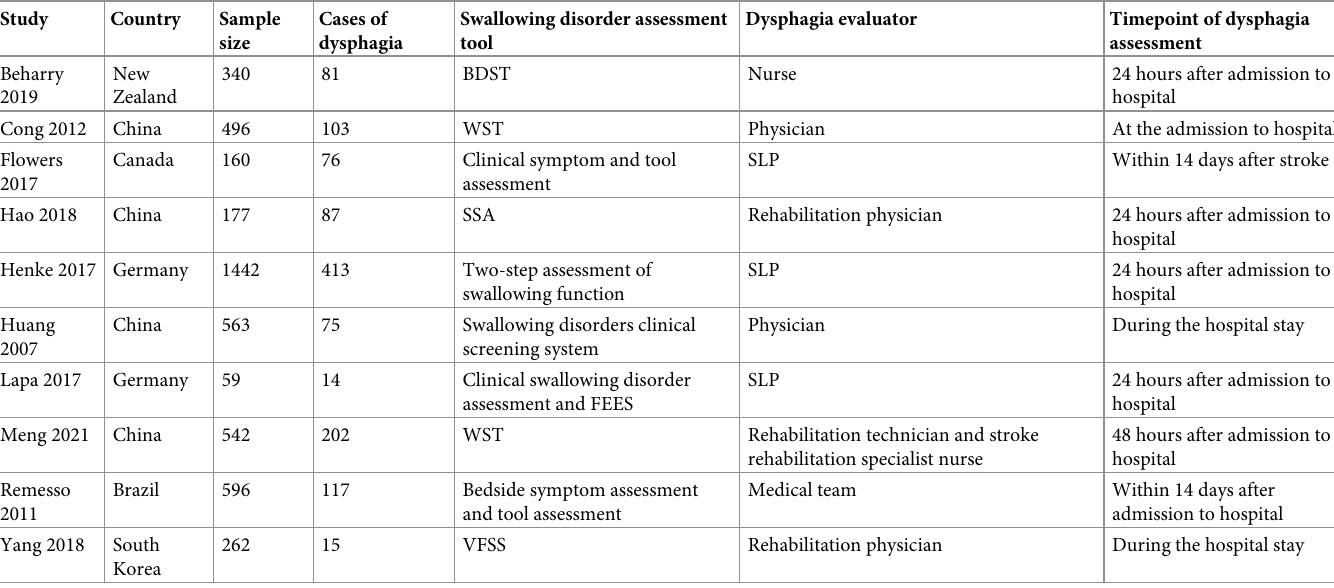
Table 1. The characteristics of included studies.